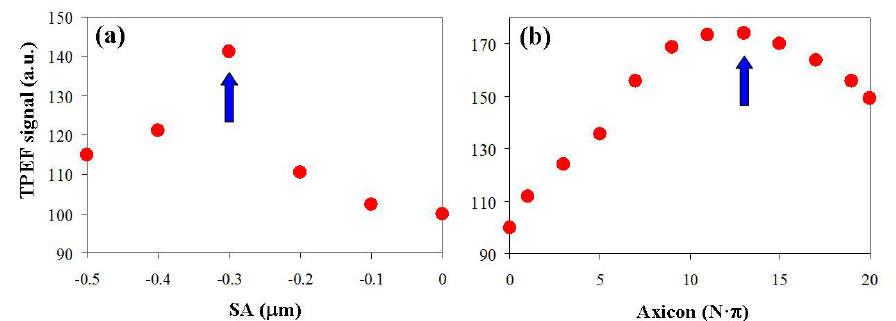
Figure 3. TPEF intensity values as a function of the amount of SA ( a ) and variable axicon ( b ) introduced by the SLM. The arrows indicate the optimum experimental conditions. The imaged plane is located at 100 μ m within the sample.